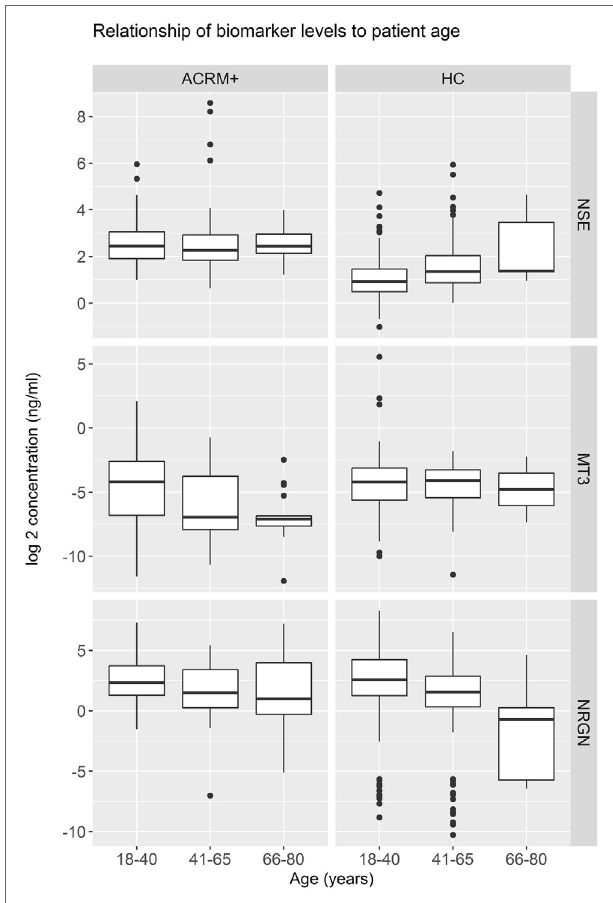
FigUre 3 | Distribution of biomarkers in mild TBI (mTBI) ACRM + and healthy control patients among different age groups. Distribution of biomarker concentrations in young, middle-aged, and older adults, analyzed separately for mTBI and the general population (328 healthy controls). For each protein marker assay, box plots show log2-transformed detected serum levels for ACRM + mTBI patients (left side of each subplot) and healthy control subjects (right side of each subplot). The red diamonds indicate the mean for the